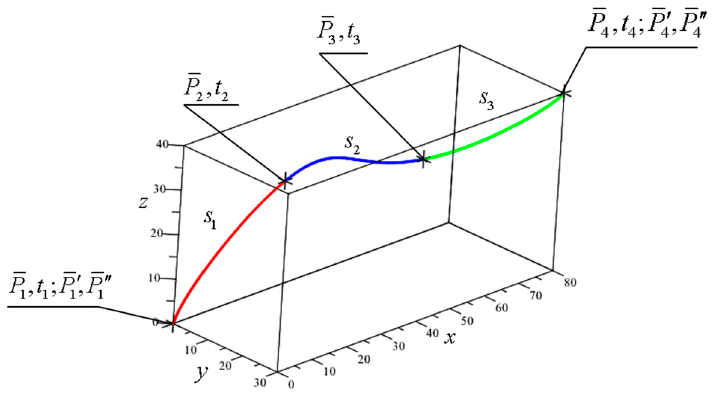
Figure 8. Fifth-degree Hermite spline curve of three segments. The values of curvature and torsion at boundary points nected segments are listed in Table 1. Table 1. Curvature and torsion values at boundary points of the segments.